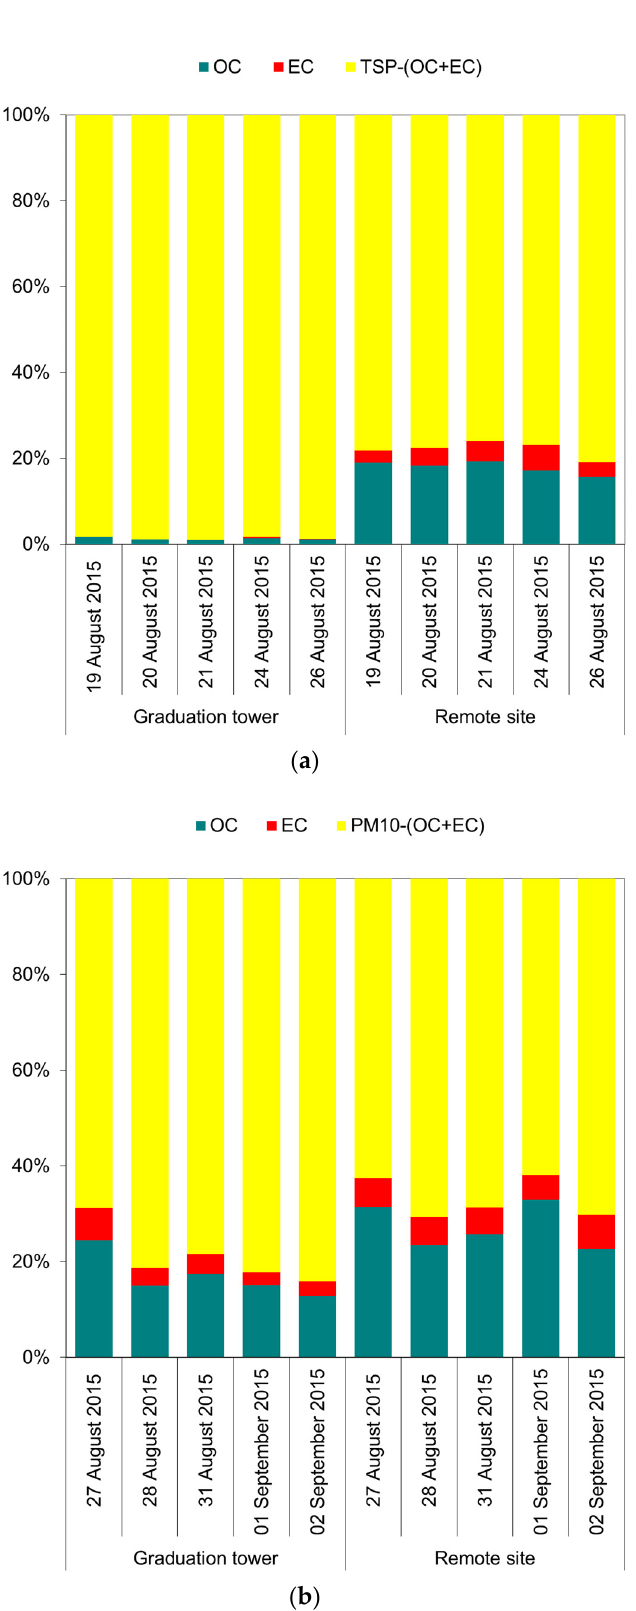
Figure 1. The contribution of organic (OC) and elemental (EC) carbon in the total mass of the TSP ( a ) and in the total mass of the PM 10 ( b ).